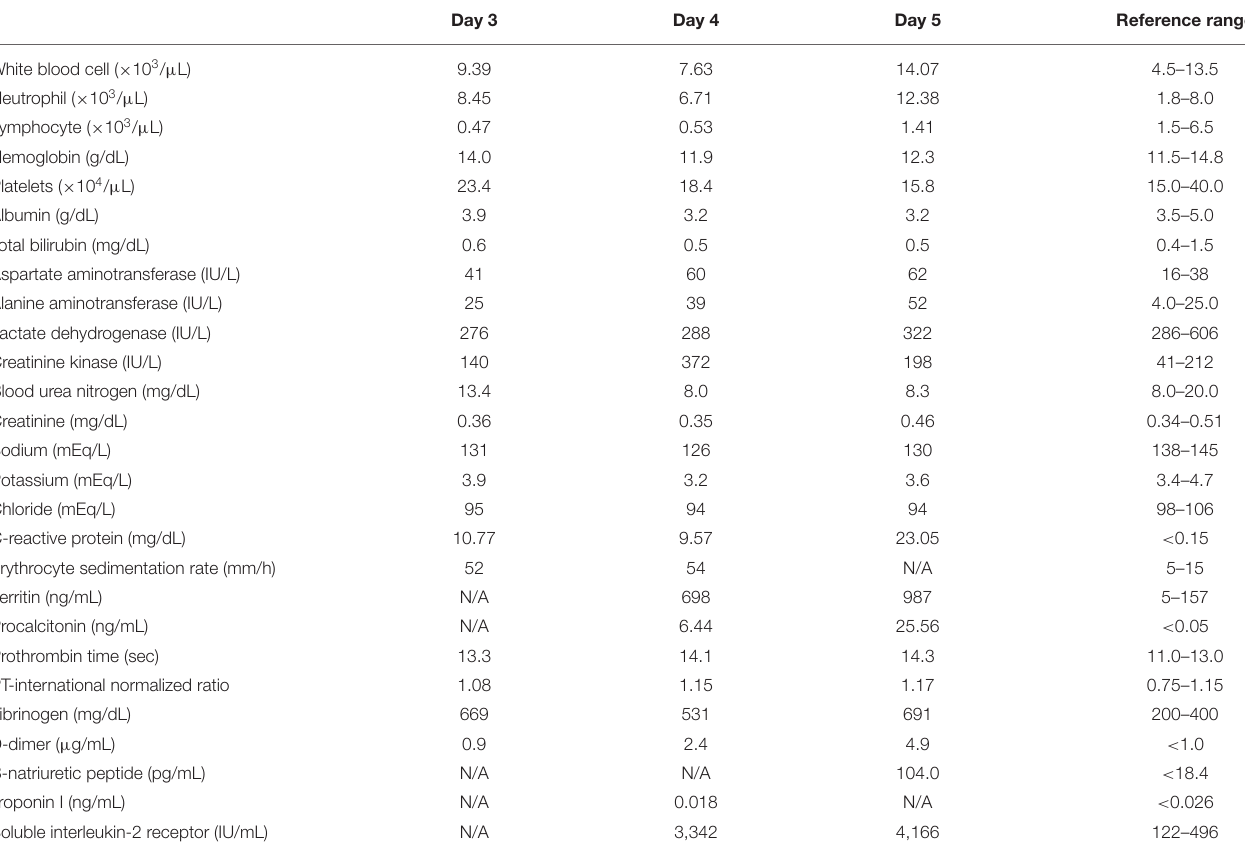
TABLE 1 | Blood test results from admission (3rd day of illness) to MIS-C diagnosis (5th day of